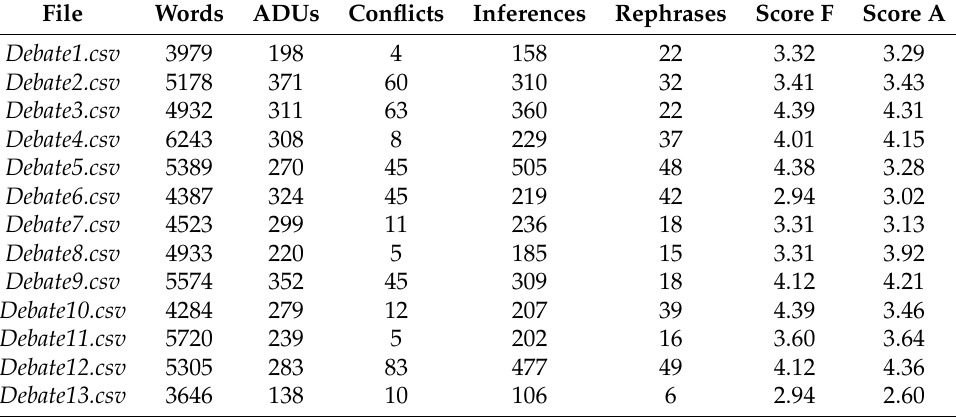
Table 4. Structure and properties of the VivesDebate corpus. Score F and A represent the score assigned to the favour and against teams respectively according to our processing of the original